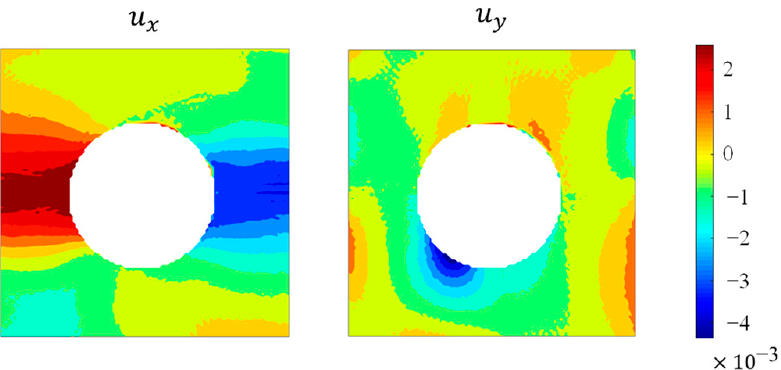
Figure 6. Absolute error derived from the PINN framework for displacements.